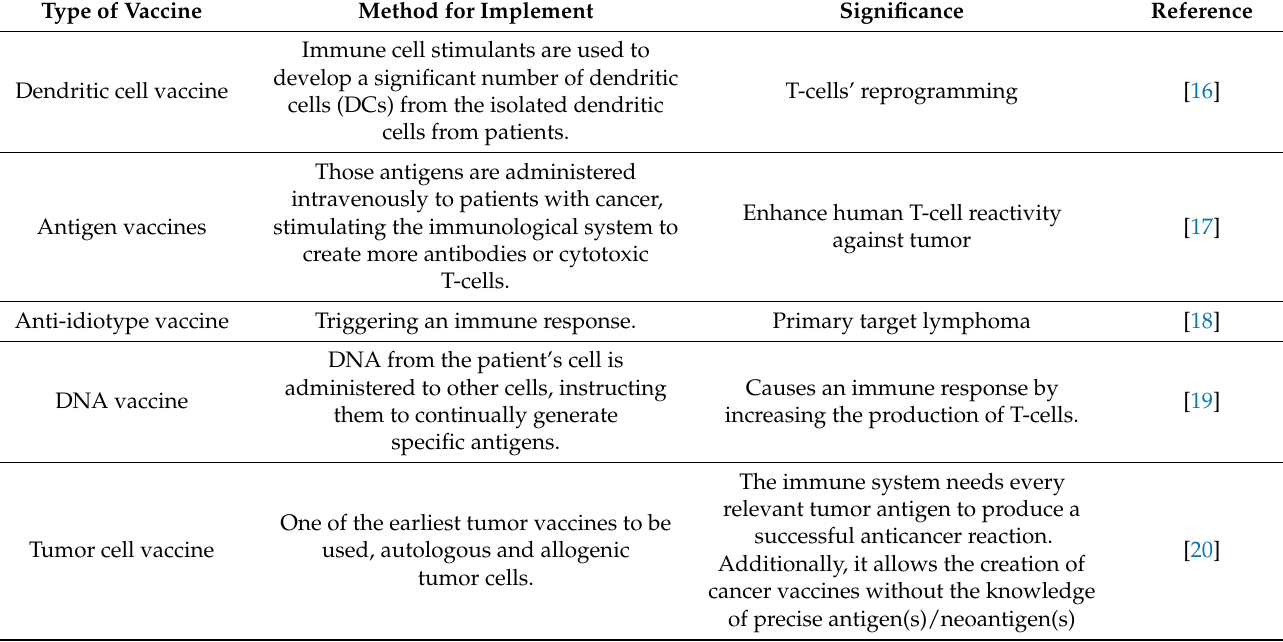
Table 1. Generally employed categories for cancer